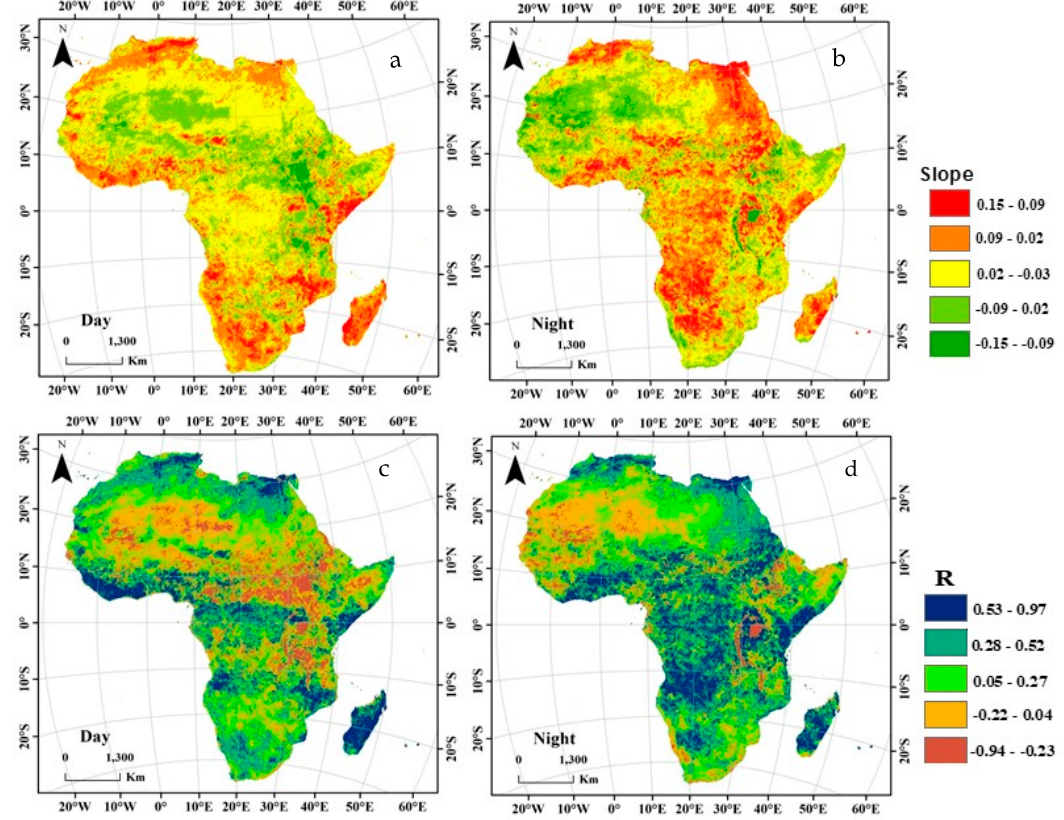
Figure 5. Spatial patterns of interannual LST changes (slope) ( a ) during the day and ( b ) at night, and correlation coefficients for ( c ) day and ( d ) night.